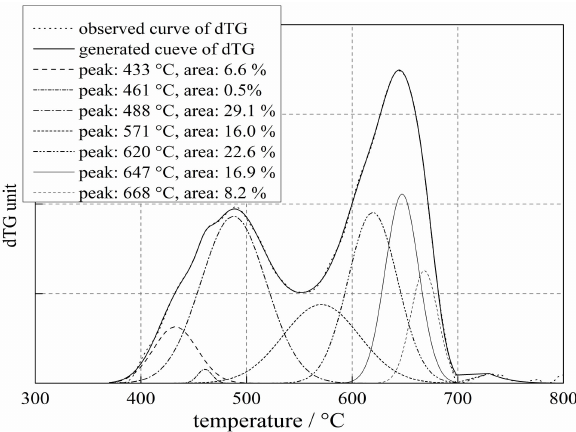
Figure8. Examplesofderivativethermogravimetry(DTG)curvesof tv / cv smectites. SampleXL_16_4JUP with 52.4% tv layers and 47.6% cv layers.